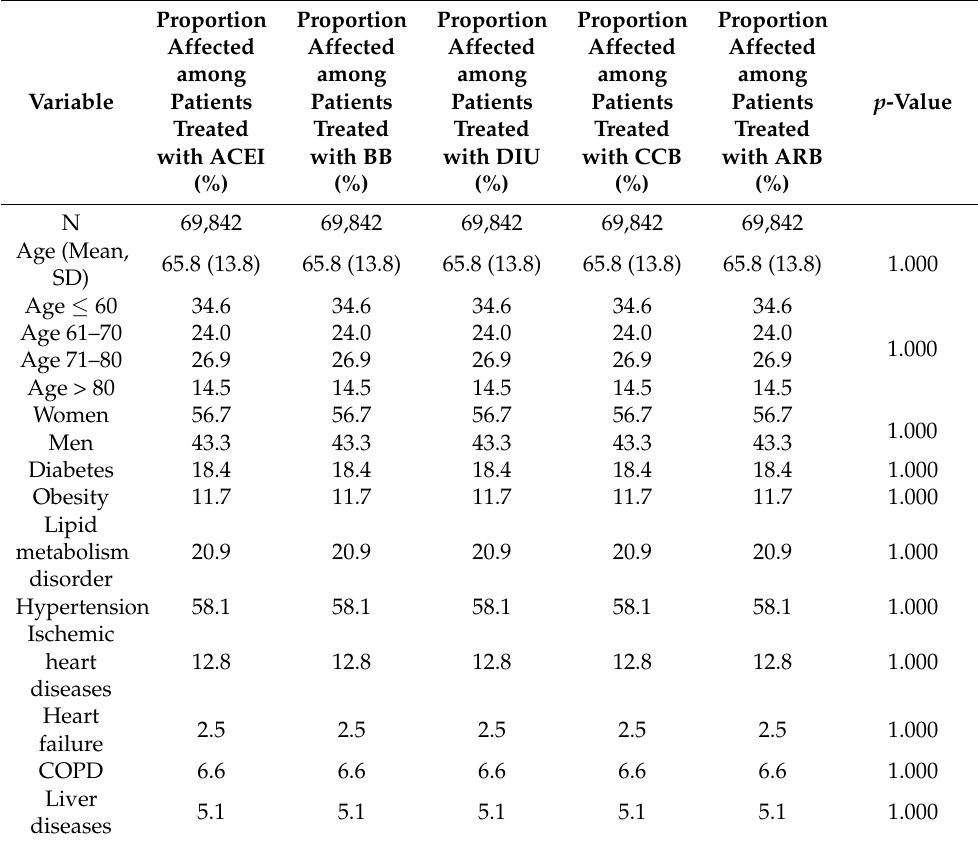
Table 1. Basic characteristics of the study sample after propensity score matching.